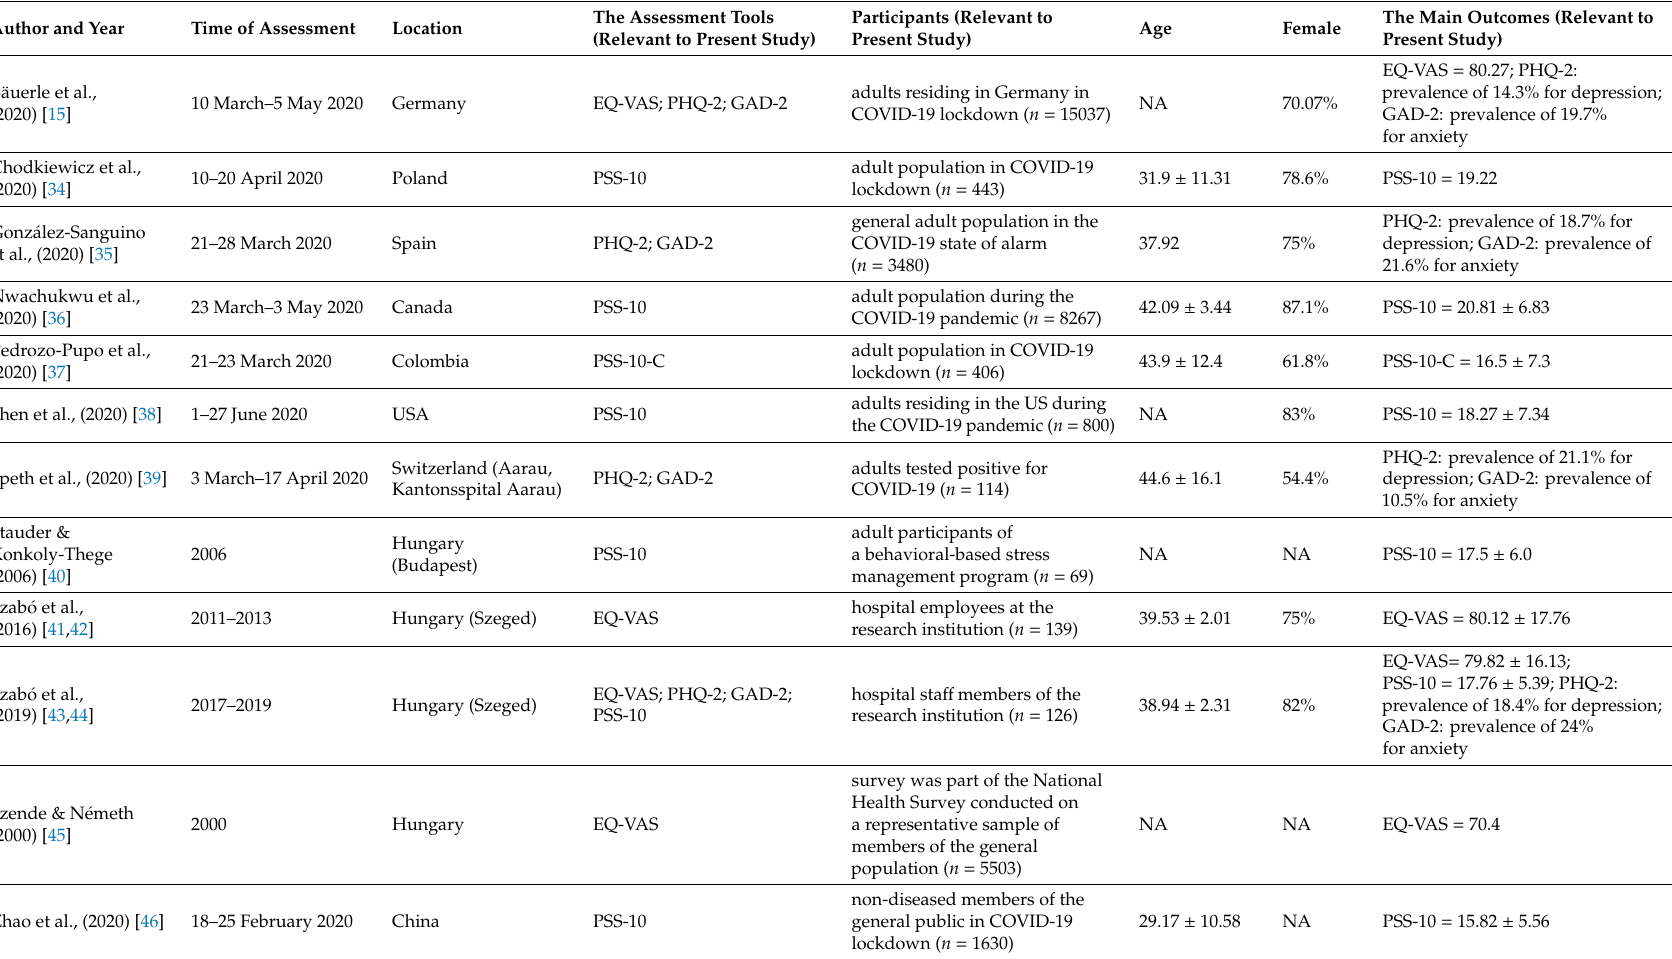
Table 1. Details of studies which used the same measuring instruments as we did for comparison of